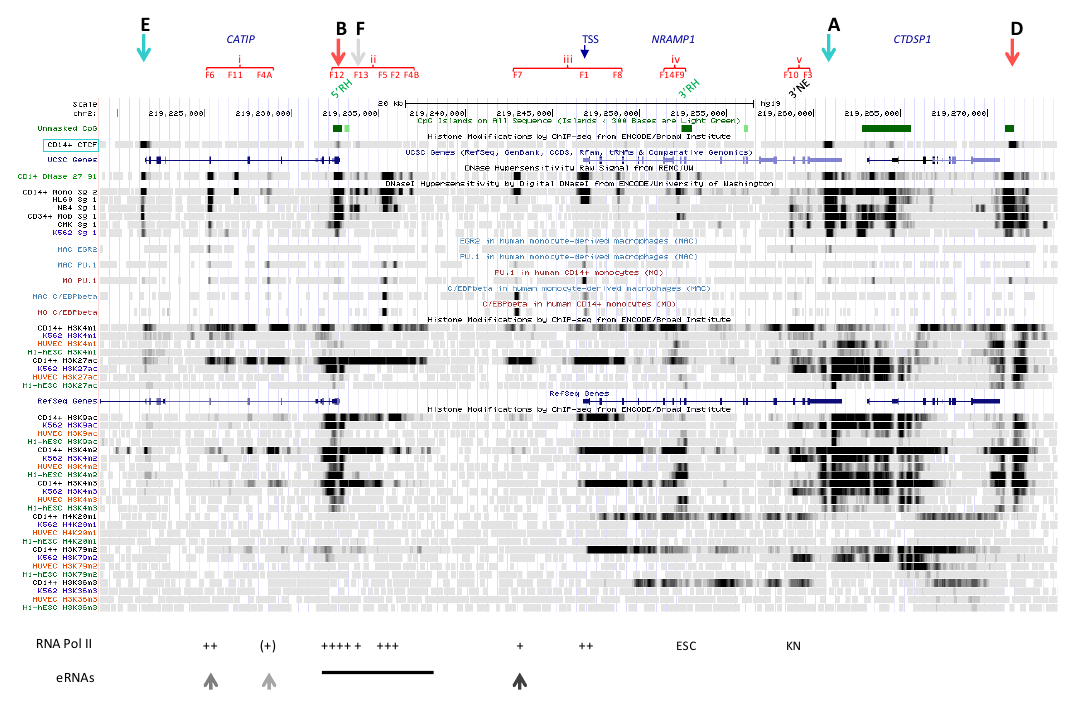
Figure 7. Epigenetic modifications and myeloid transcriptional regulatory elements at NRAMP1 locus (data from ENCODE consortium [9,10,78] or stated otherwise). From top to bottom: Gene names, location of CTCF sites delineating NRAMP1 locus (light blue arrows, A and E) and CTDSP1 gene (red arrow, D) and position of NRAMP1 TSS (blue arrow); chromosome segments comprising transcriptionally active regions; position of DHSs (F1-F14), RHs and negative element (NE); chromosome 2 scale; CpG islands; CTCF sites in CD14 + MNs; UCSC gene descriptions; DNAse1 footprints in CD14 + MNs, HL-60, NB4, mCD34, CMK and K562 cells; EGR2, PU.1 and C/EBPb ChIP-seq data from MO and MAC [13]; H3K4me1 and H3K27ac ChIP-seq data from CD14 + MNs, K562 cells, HUVEC and ESC; RefSeq genes; H3K9ac, H3K4me2, H3K4me3, H4K20me1, H3K79me2 and H3K36me3 ChIP-seq data from CD14 + MNs, K562 cells, HUVEC and ESC; areas bound by RNA Pol II in HL-60 cells, except ESC (Embryonic stem cells) and KN (K562 and NB4 cells); eRNAs: major